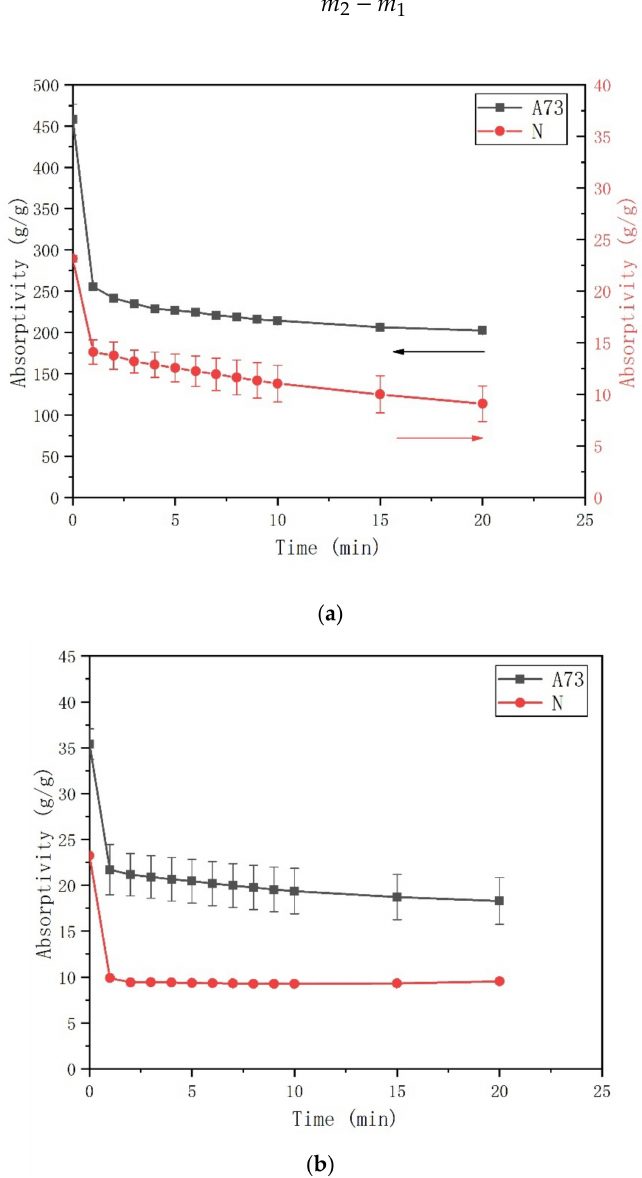
Figure 2. Absorption of the superabsorbent polymer (SAP) at 30 min as a function of centrifugation time: ( a ) deionized water and ( b ) cement